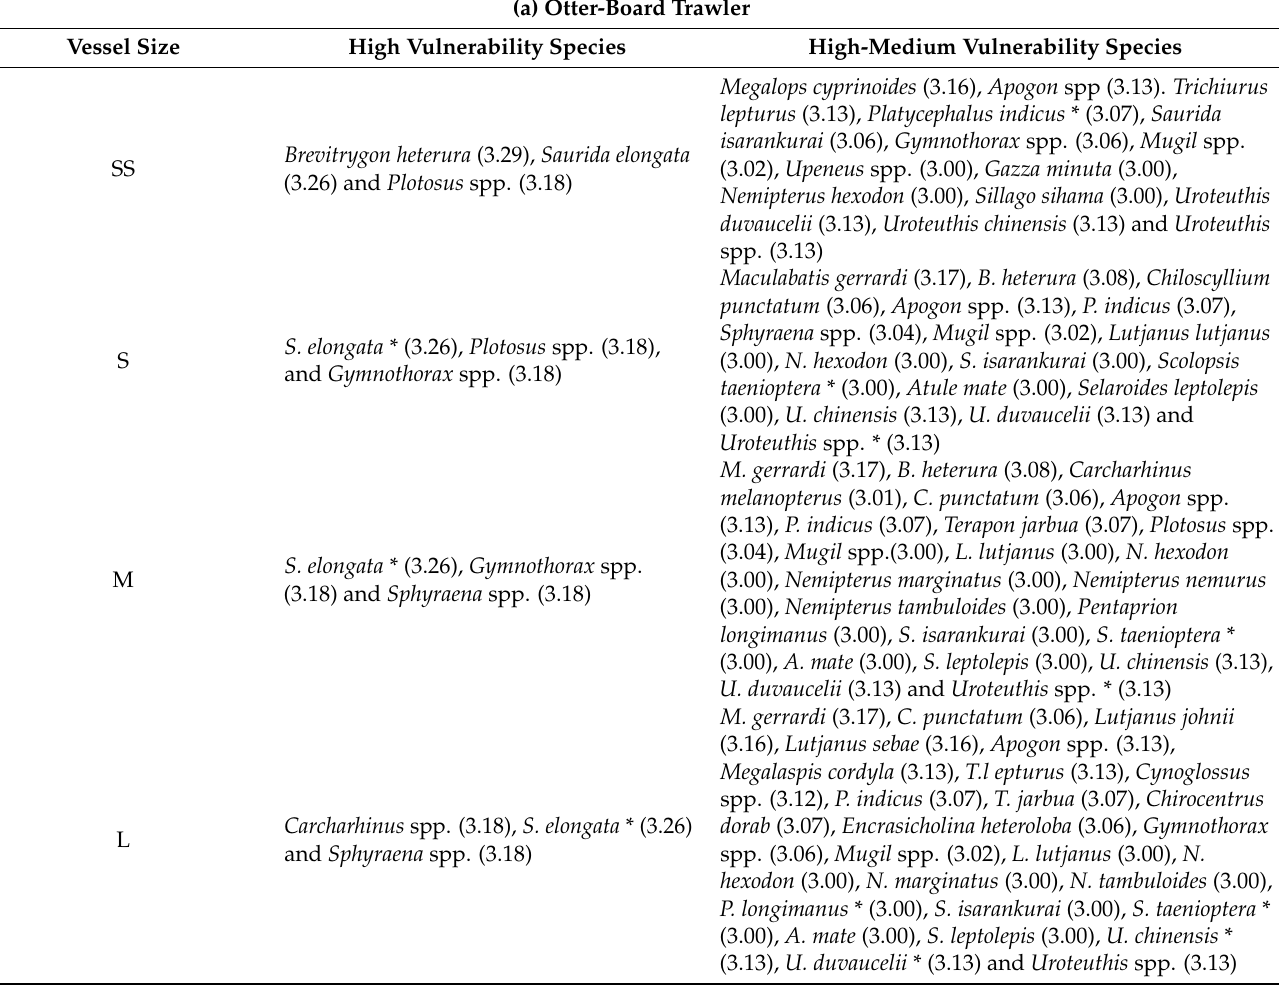
Table 3. List of high and high-medium vulnerability species in the trawl fishery in the Gulf of Thailand by each trawl-type and vessel size with its V-score in parentheses. Species with * indicates that they were among the top ten species caught, in terms of weight, by the trawlers. (a) Otter-Board Trawler Vessel Size High Vulnerability Species High-Medium Vulnerability Species